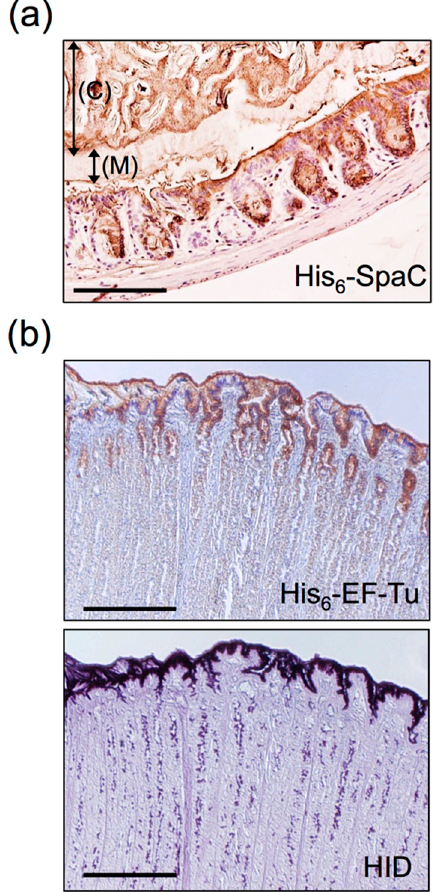
Figure 6. Histochemical staining of the Methacarn-fixed GI mucosal surface with recombinant proteins. (a) Binding of His 6 -SpaC was observed on the murine colonic mucosa. Arrows indicate the gut contents (C) and the mucus layer (M). Scale bar: 200 µ m. Based on the results of Nishiyama et al. [47]. (b) Binding of His 6 -EF-Tu was observed on the porcine gastric mucosal surface (upper panel). These areas were coincident with areas positively stained for high iron diamine (HID) (lower panel). Scale bars: 1000 µ m. Based on the results of Nishiyama et al. [86].